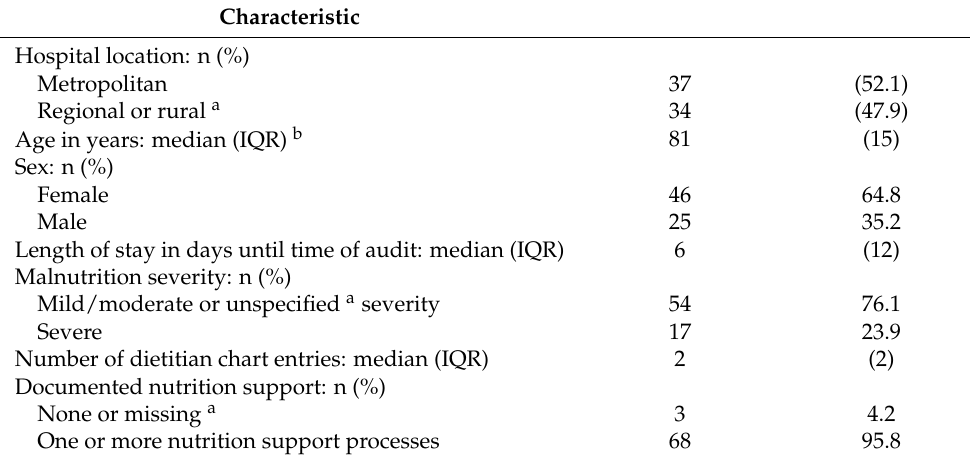
Table 2. Characteristics of included patients.